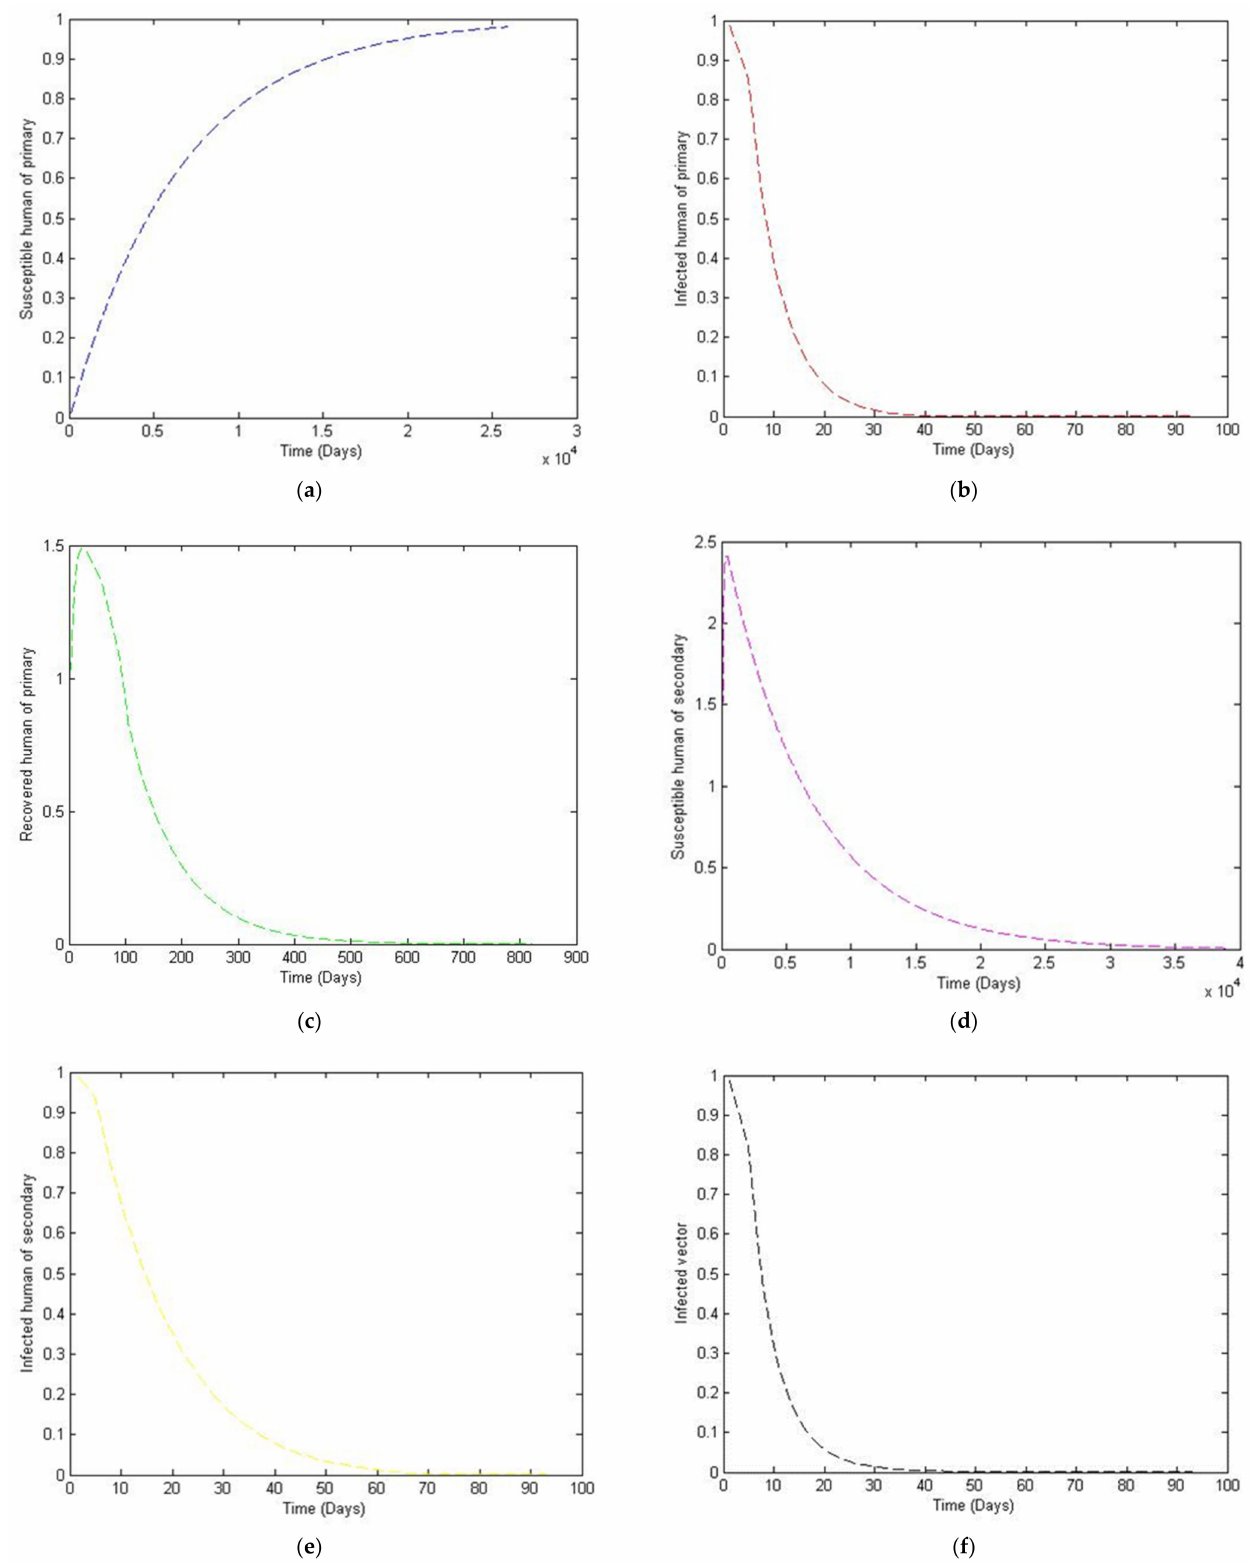
Figure 3. The trajectory of S HP , I HP , R HP , S HS , I HS and I V toward the disease-free equilibrium point for R 0 < 1 with parameter values according to Table 1. ( a ) Susceptibles of primary infection ( b ) Infected population with primary infection ( c ) Recovered human of primary infection ( d ) Susceptibles of secondary infection ( e ) Infected human of secondary infection ( f ) Infected